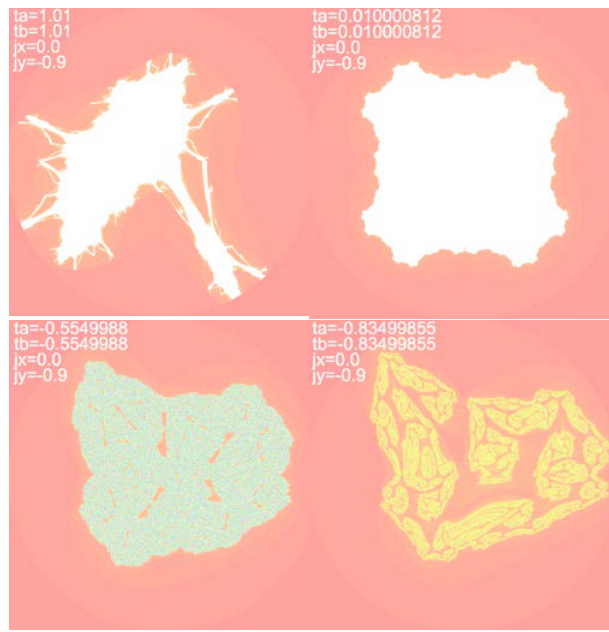
Fig.4. Diagrams for “deformed burning ship” map